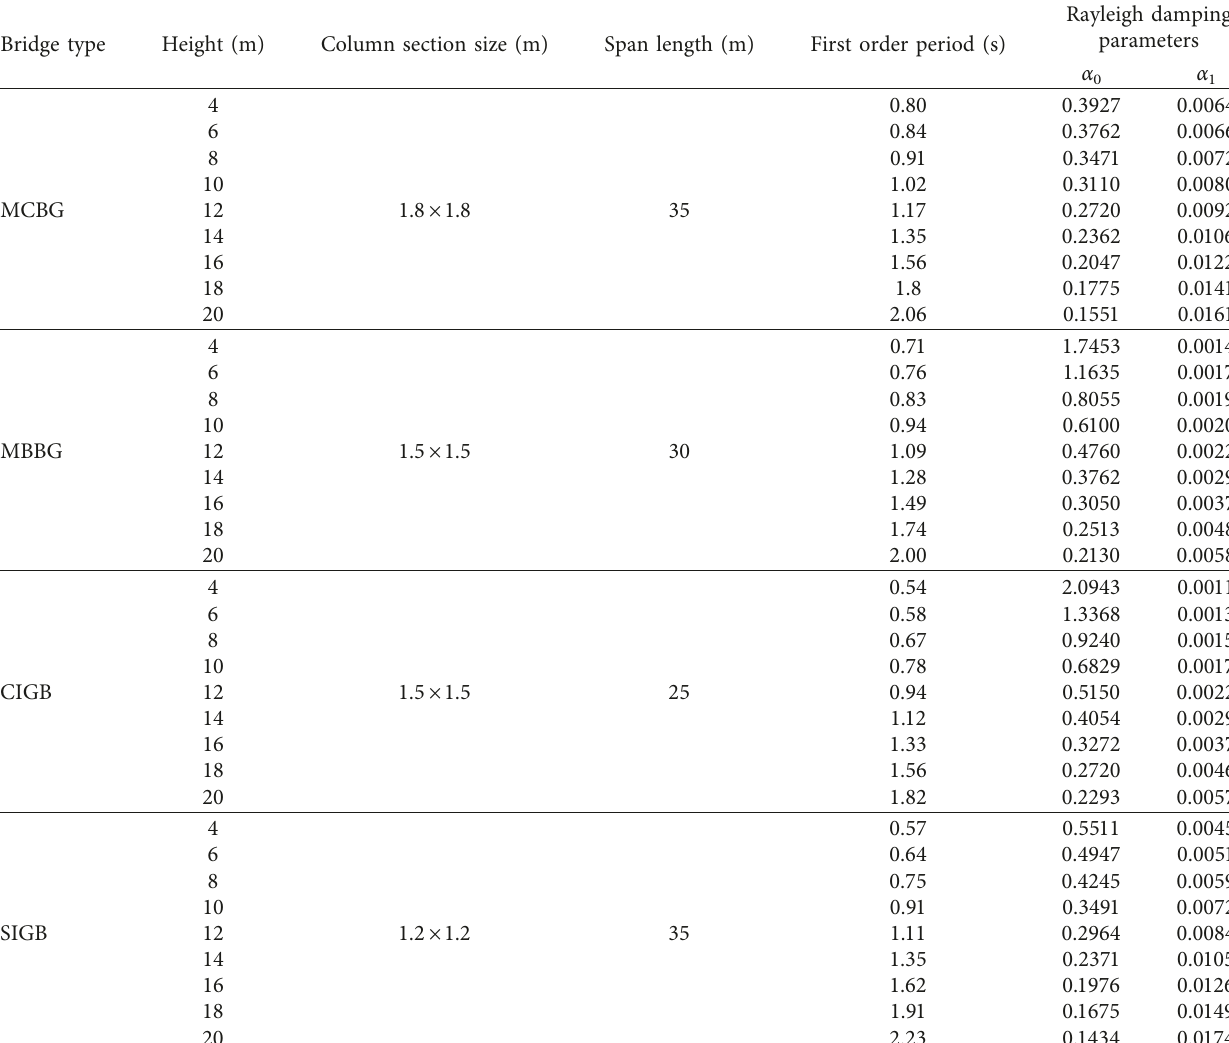
Table 2: Characteristics of the four isolated girder bridge types.